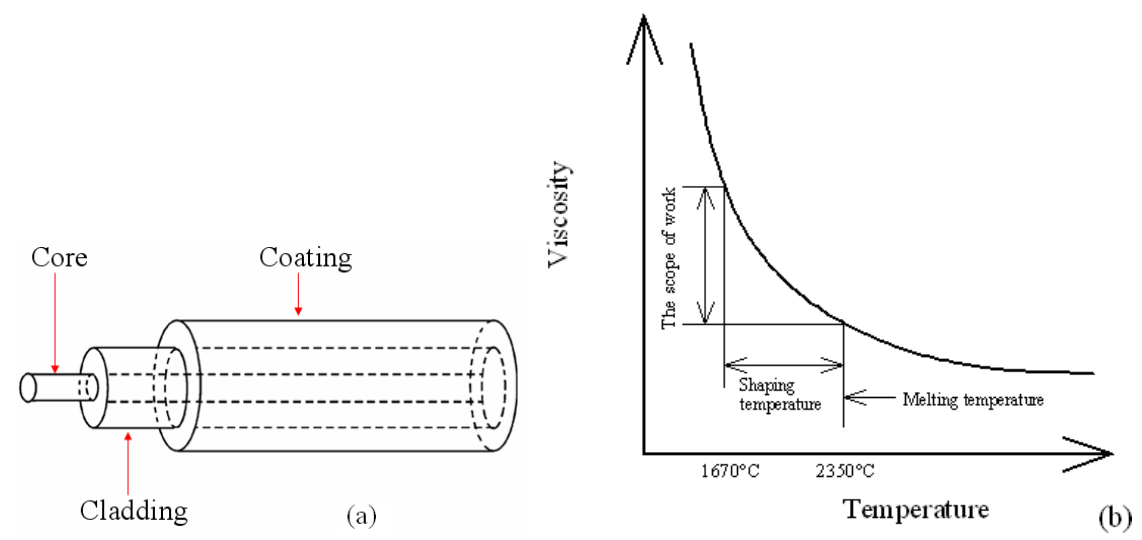
Figure 8. ( a ) Inner structure of the SM optical fiber; ( b ) Relation curve of the optical fiber between temperature and